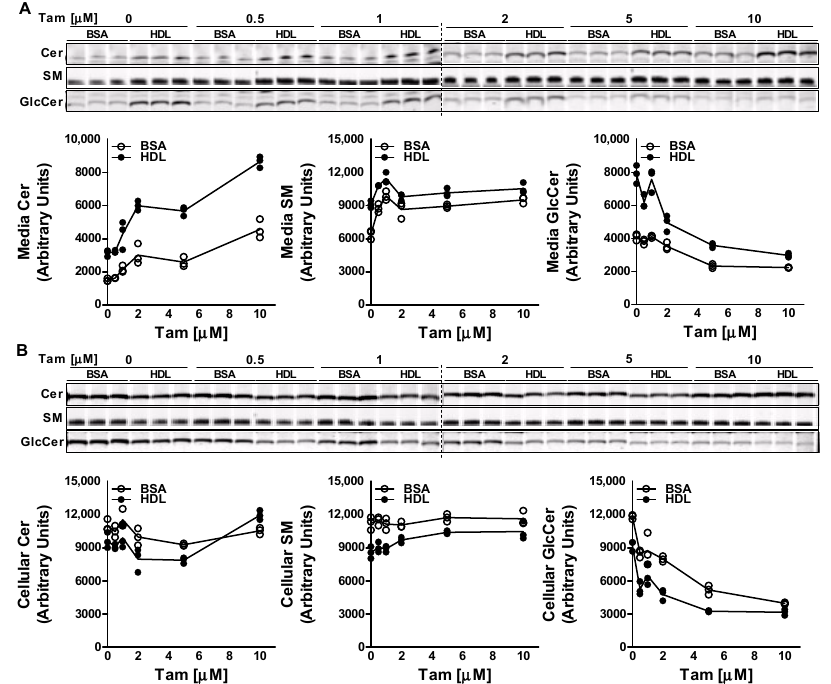
Figure 2. Effect of tamoxifen on the efflux and synthesis of GlcCer. Huh-7 cells were treated with different doses (0–10 µM) of tamoxifen (Tam) for 17 h, labeled with 2 µM of C6-NBD ceramides in 10% FBS containing DMEM for 3 h, washed three times with 0.1% BSA containing DMEM, and then incubated with either 40 µg/mL BSA or HDL for 6 h to study sphingolipid efflux. Lipids in the media ( A ) and cells ( B ) were extracted and separated on TLC plate, and fluorescence in Cer, SM, and GlcCer bands was visualized with the PhosphorImager and quantified using ImageJ software (plotted below each TLC image). Values are plotted as